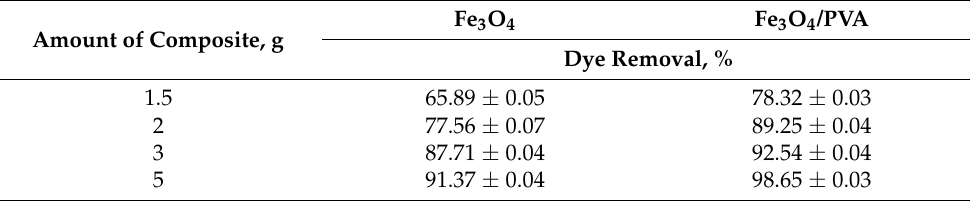
Table 1. Dye removal percentage values for composite at different amounts of